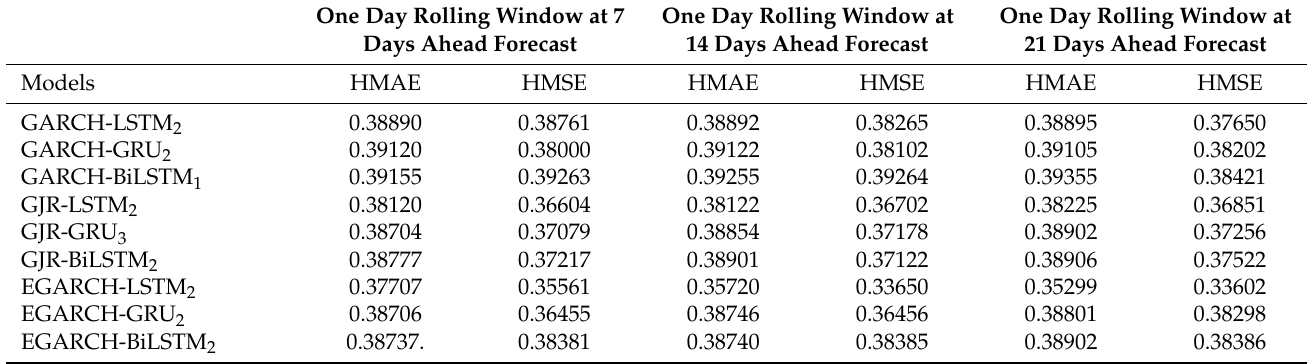
Table 5. Out-of-sample forecast results for single GARCH-type models hybrid with DL models, with fixed rolling-window size at different forecasts horizons. One Day Rolling Window at